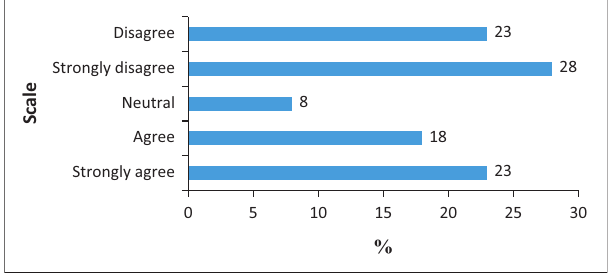
FIGURE 2: Political connections used in the allocation of low-cost houses. FIGURE 3: Promises can lead to joining a